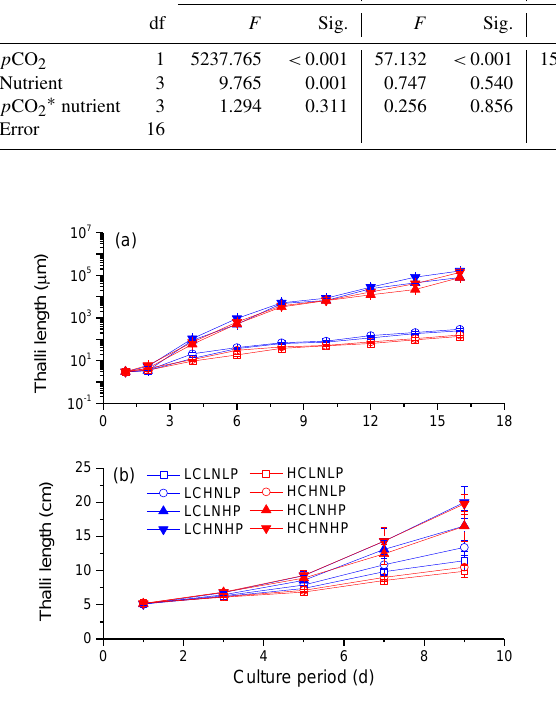
Figure 1. Length changes in young (a) and adult (b) U. linza grown under various conditions during the culture periods. LC, 400µatm; HC, 1000µatm; LN, 6.1µmolL − 1 ; LP, 0.2µmolL − 1 ; HN, 106.1µmolL − 1 ; HP, 10.2µmolL − 1 . The error bars indicate the standard deviations ( n = 3).